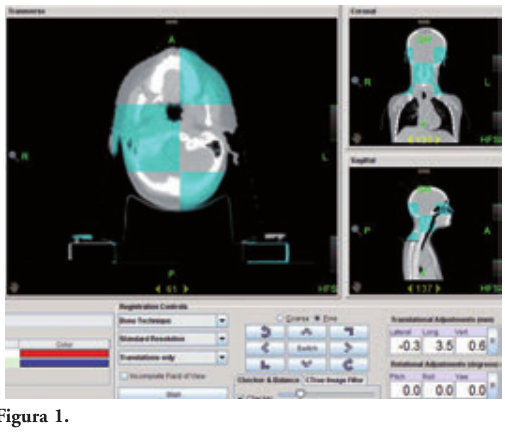
RISULTATI: Le tossicità acuta e tardiva sono state valu- tate secondo la scala CTCAE4.02 non rilevando